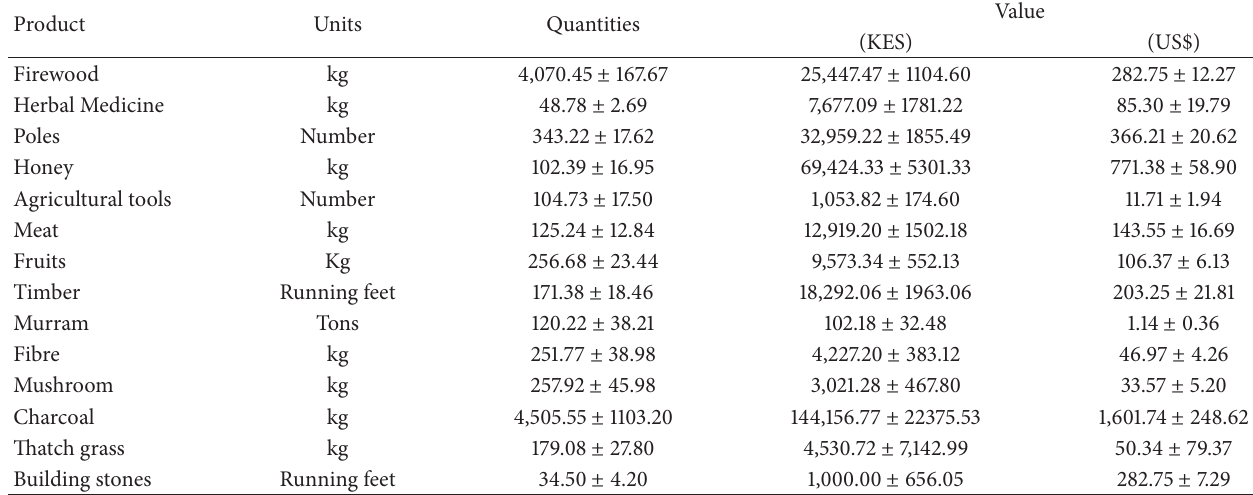
Table 3: Quantities and monetary value of forest products collected by households per year.